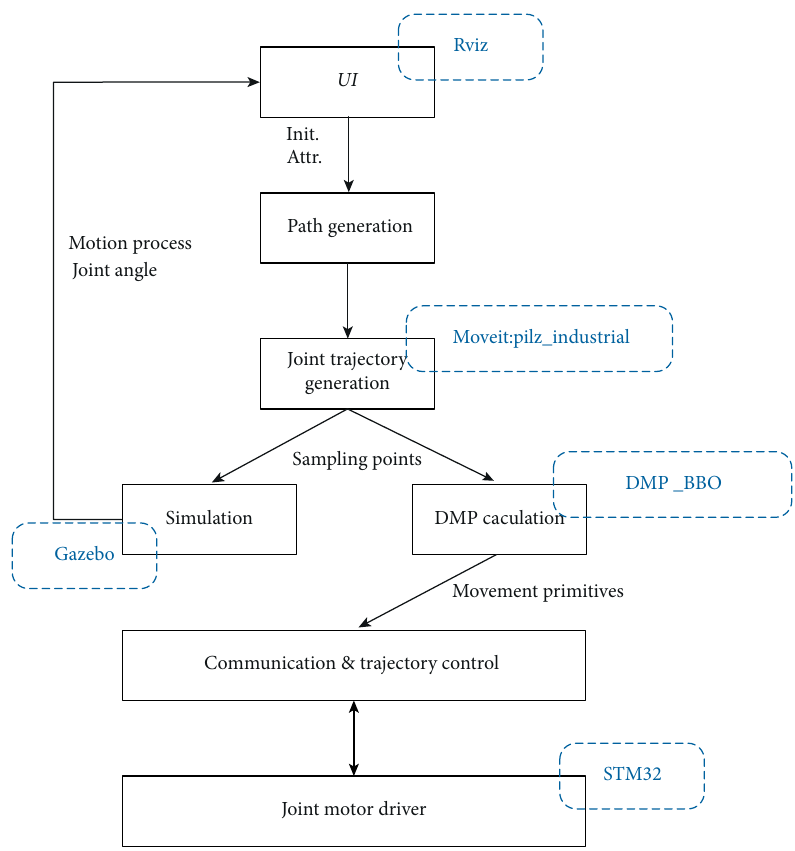
Figure 10: Experimental platform framework. Blue dashed boxes are the main software packages on the system.